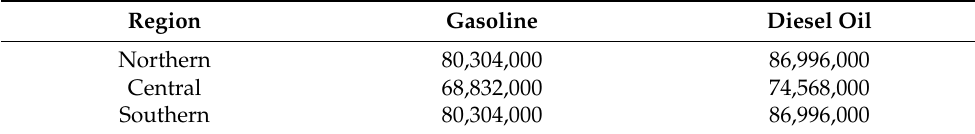
Table A1. Annual domestic demand (barrel).